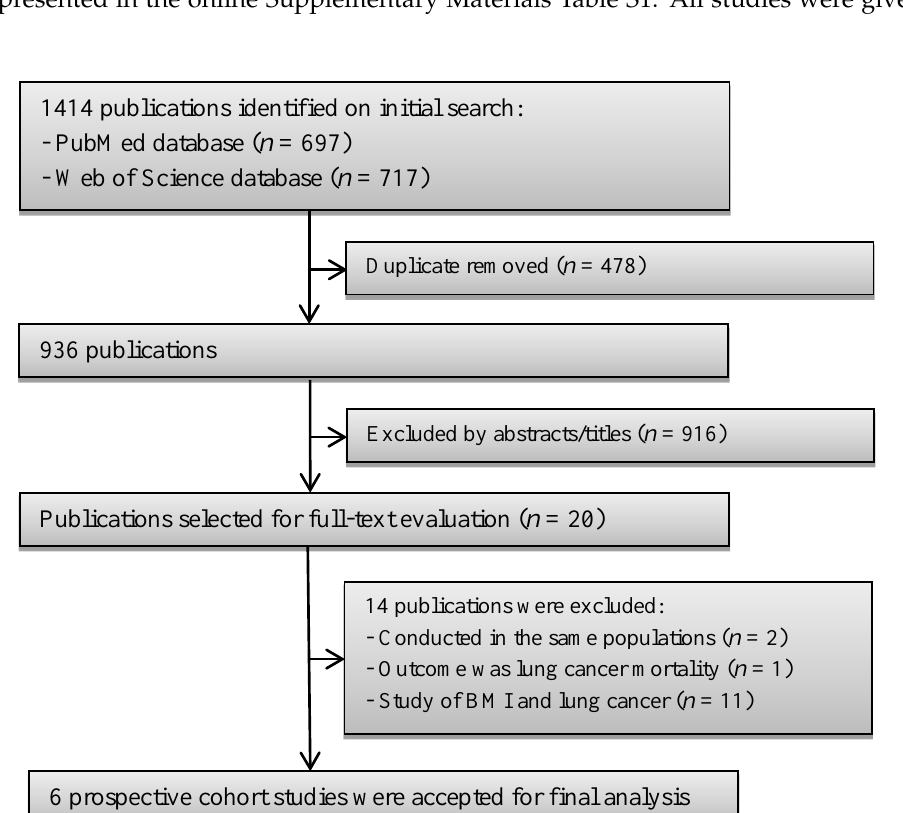
Figure 1. Flow chart of study selection